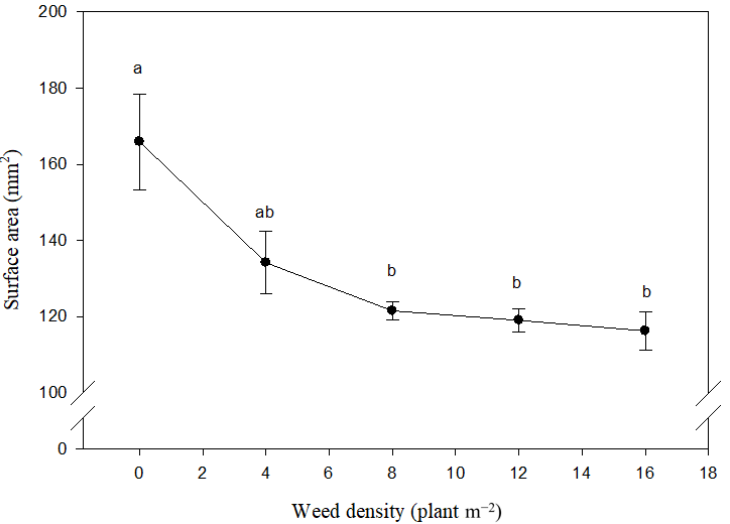
Figure 3. Effect of different density of Xanthium strumarium and Datura stramonium on maize seed surface area. Mean values with the same letters are not significantly different based on Tukey’s studentized range test ( p ≤ 0.05). Vertical lines are standard error of mean ( n = 12; two years, two weed species and three replications).